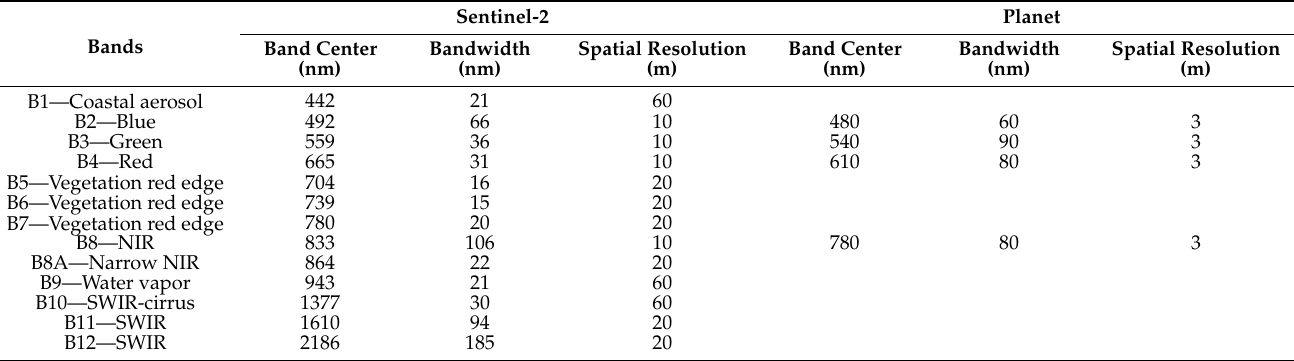
Table 2. Sentinel-2 and Planet band configurations.